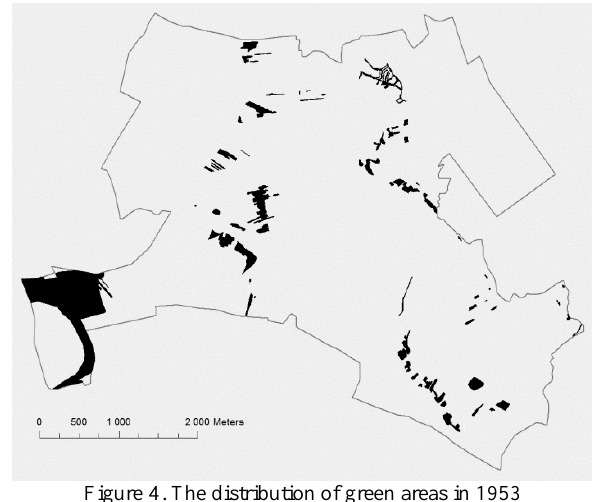
Figure 4. The distribution of green areas in 1953